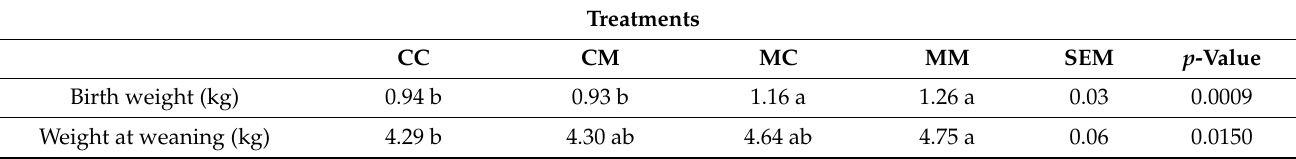
Table 4. Productive performance evaluated in piglets descended from sows distributed in the CC treatments: control-control; CM: control-music; MC: music-control; MM: music-music. Treatments